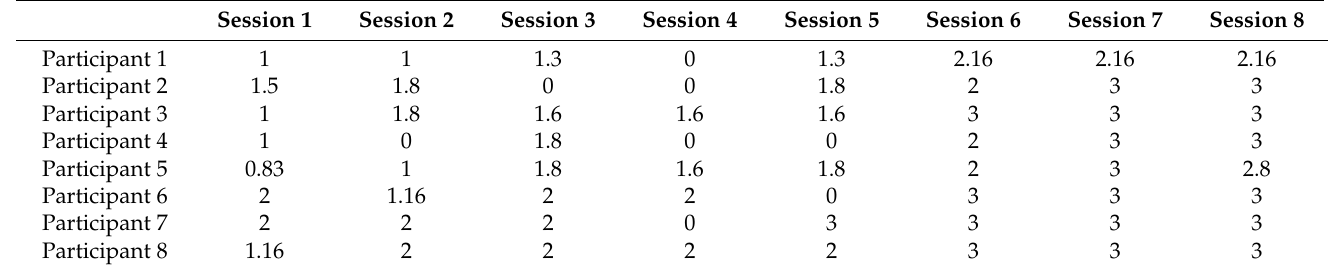
Table 3. Enjoy the emotions by